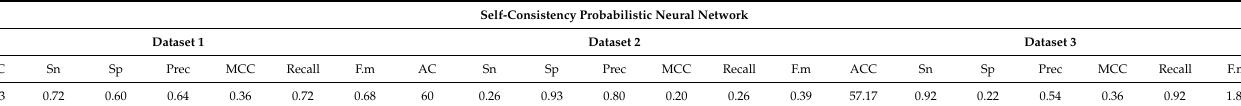
Table 7. Self-consistency test result for probabilistic neural network.